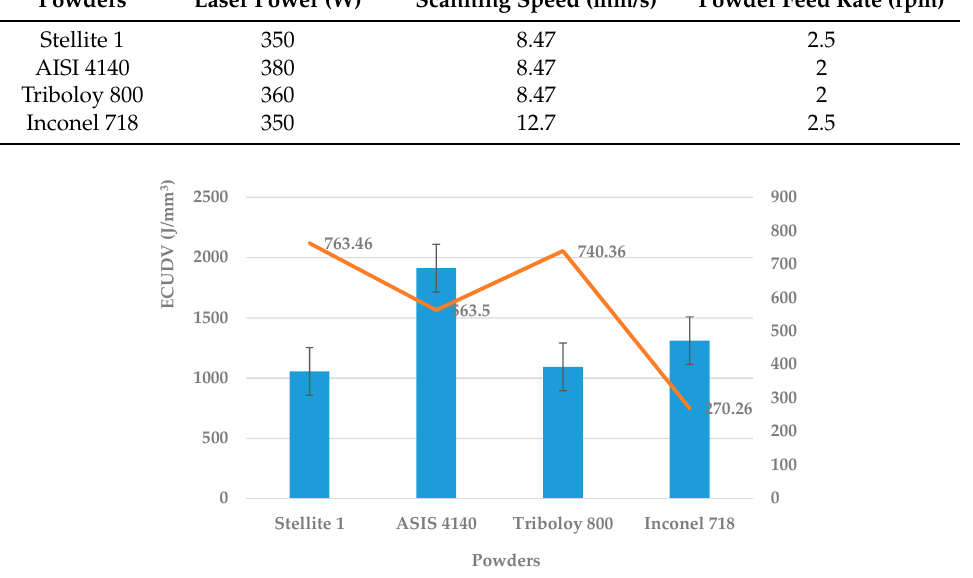
Figure 10. Effect of powder materials on energy consumption and microhardness.